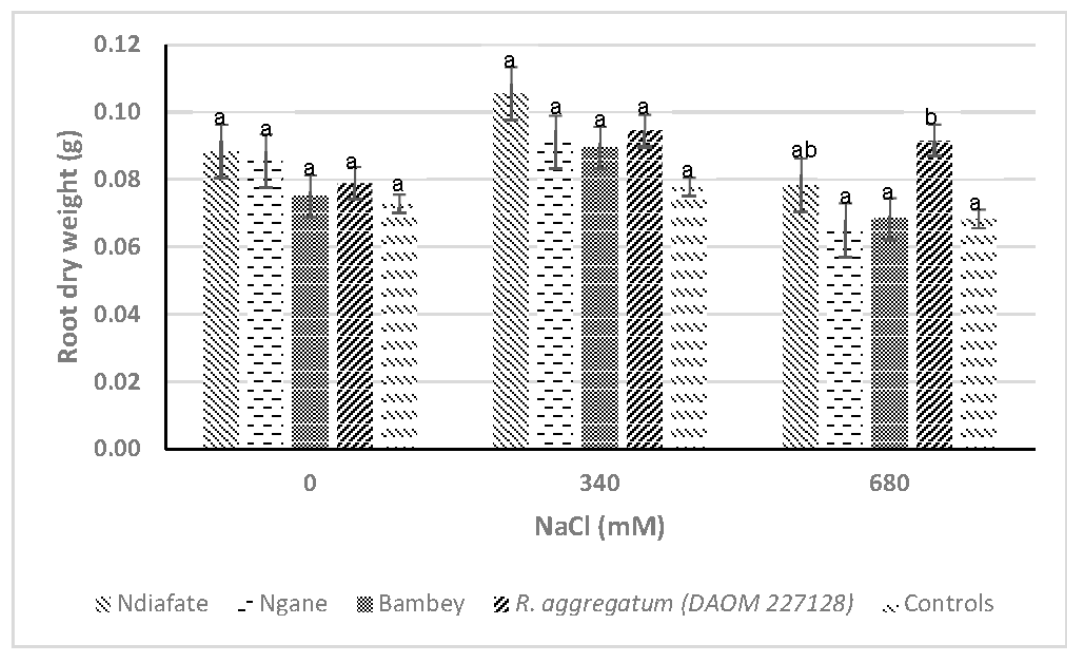
Figure 4. The effect of the AMF isolates × NaCl interaction on the dry biomass of the shoot parts of A. seyal seedlings after 30 days of culture. Ndiafate, Ngane, and Bambey correspond to high, mod- erate, and low salinity zones, respectively where the AMF were collected. Bars with the same letters for each variable are not significantly different at p < 0.05 (Newman – Keuls test) and error bars rep- resent standard error of the mean ( n = 270).